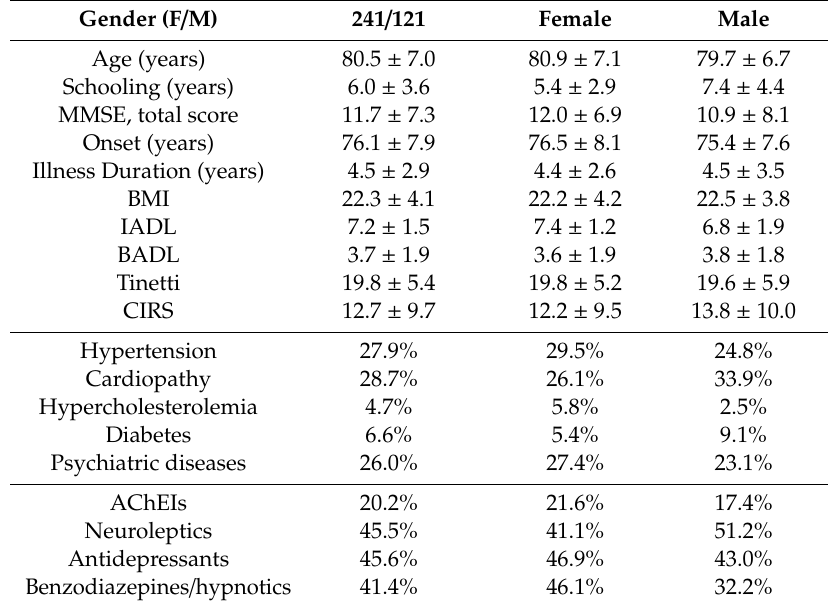
Table 1. Clinical features of our Alzheimer’s Disease Italian cohort, stratified according to gender.